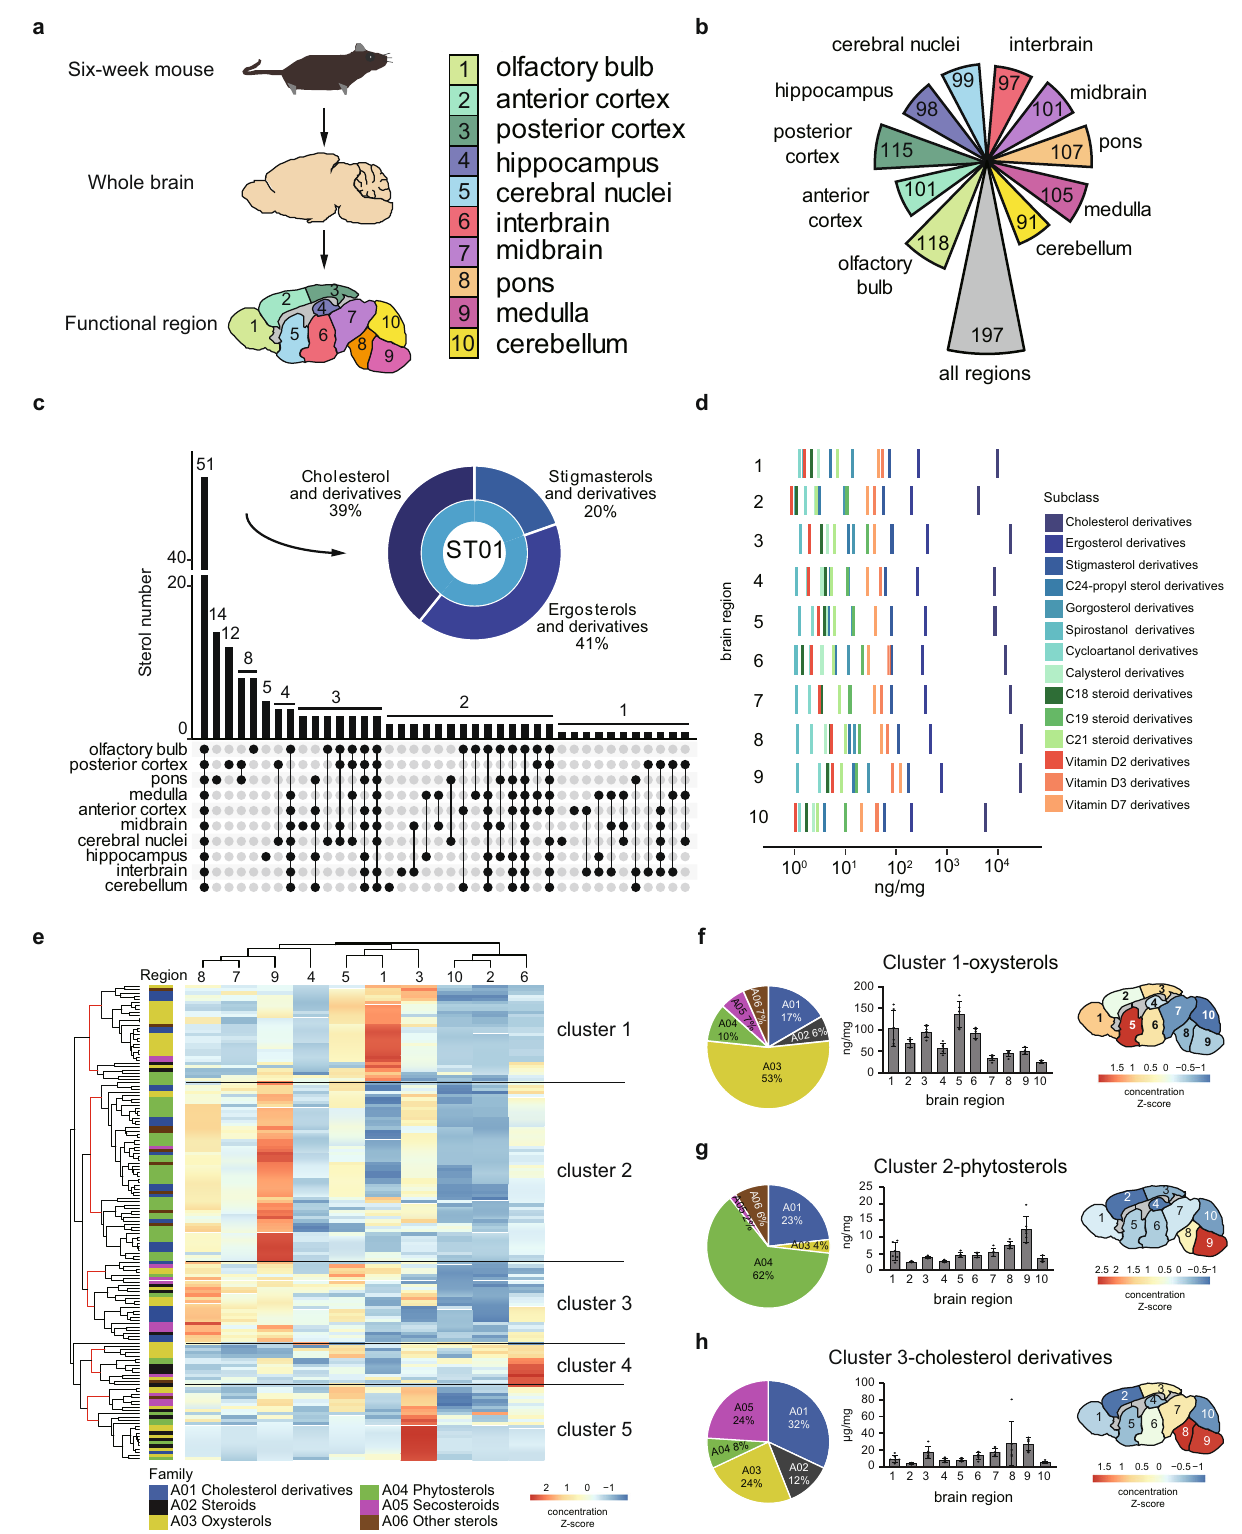
Fig. 5 Spatial characterizations of sterol lipids in the mouse brain. a Dissection of functional regions of mouse brains (6-week; n = 6 biologically independent samples for each group). Each sample was analyzed once by LC-IM-MS. b Numbers of sterol lipids identi fi ed in the brain regions. c The distributions of shared and unique sterol lipids in the brain regions. Each column represents the number of sterol lipids identi fi ed in the speci fi c brain regions, which were shown as black solid dots in the lower part of the plot. d Absolute concentrations of sterol lipids in 14 sterol subclasses measured in the brain regions. The sterol concentrations were normalized to tissue wet weight (mg). e Hierarchical clustering analysis of sterol lipids in mouse brain regions ( n = 149). f – h Percentages of sterol subclasses in clusters 1 – 3 and concentration distributions of representative sterol subclasses in mouse brain regions. Data are presented as mean values + / − SD ( n = 6 biologically independent samples for each